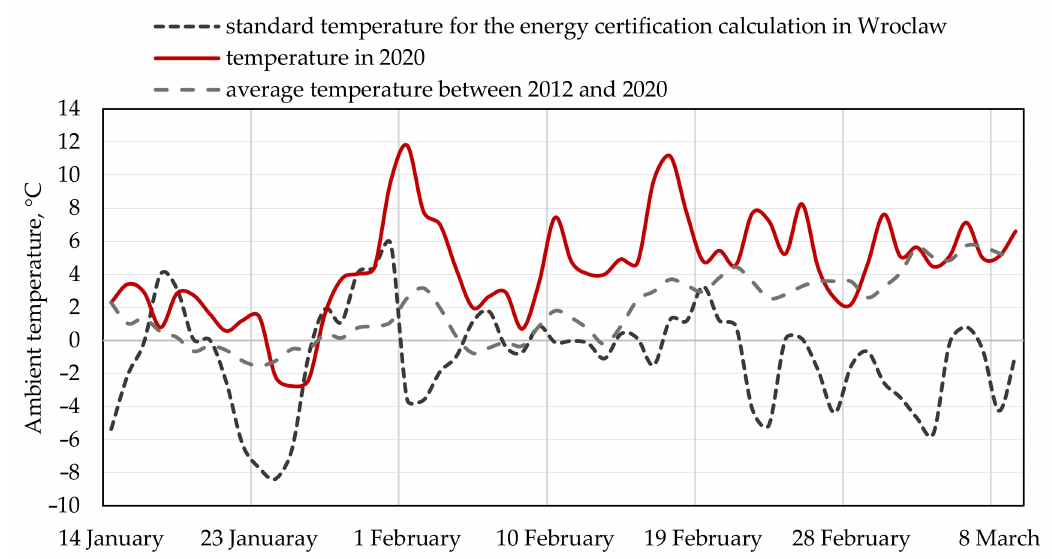
Figure 2. Average daily ambient temperatures in Wroclaw in the selected